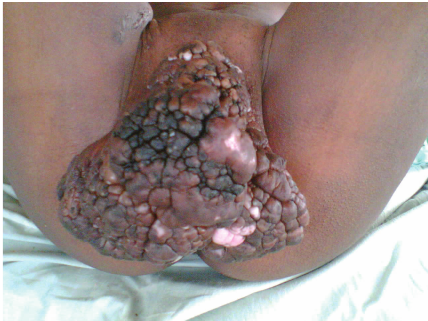
Figure 2: The giant condyloma completely excised along with the labia majora. Incision was closed with interrupted